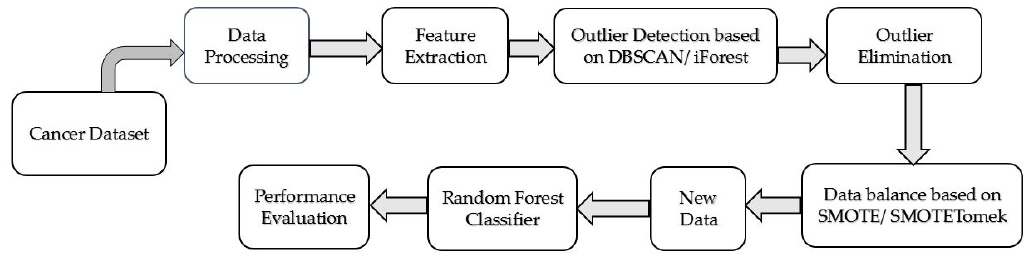
Table 2. Performance metrics for the classification model.